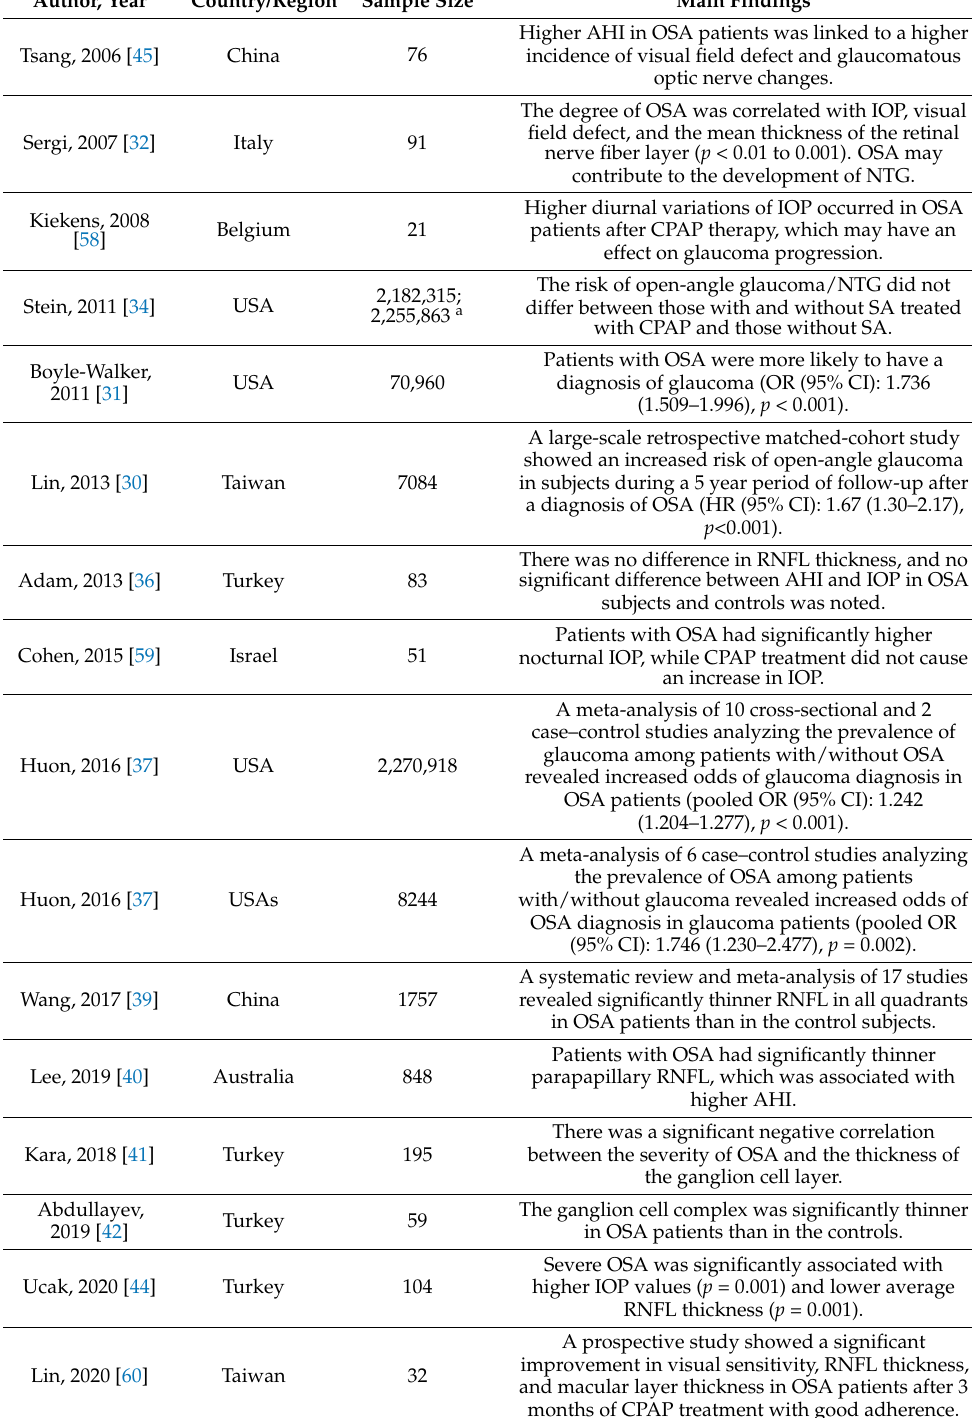
Table A1. Summary of the major studies evaluating the association between OSA and